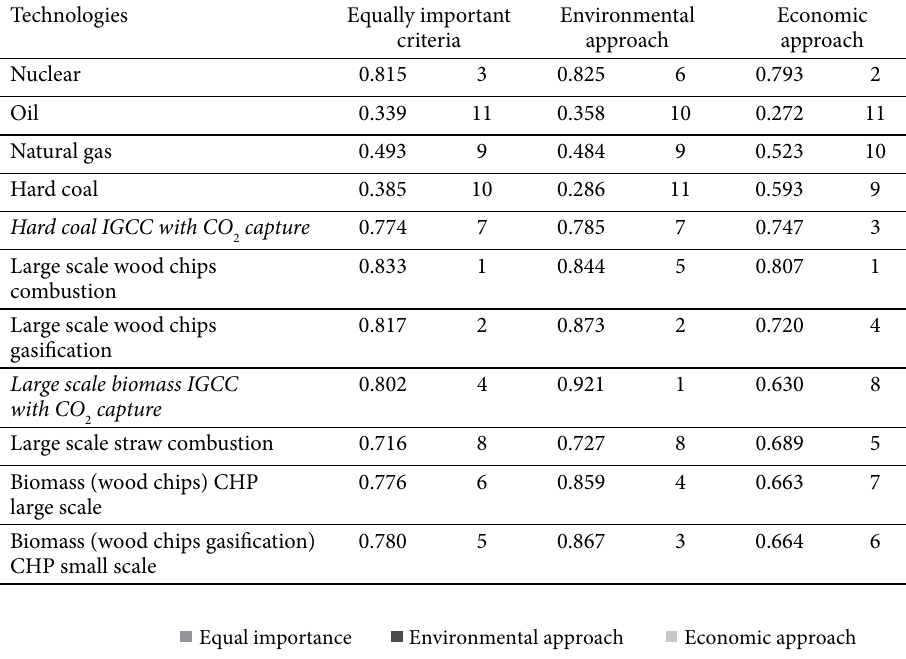
Table 4. Closeness coefficients (CC) and ranks for energy technologies Technologies